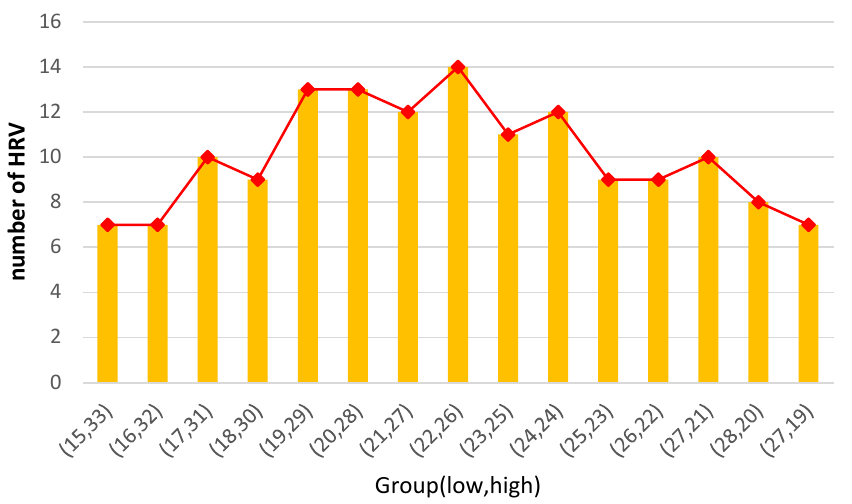
Figure 8. Normal distribution of participants by QQ plot.